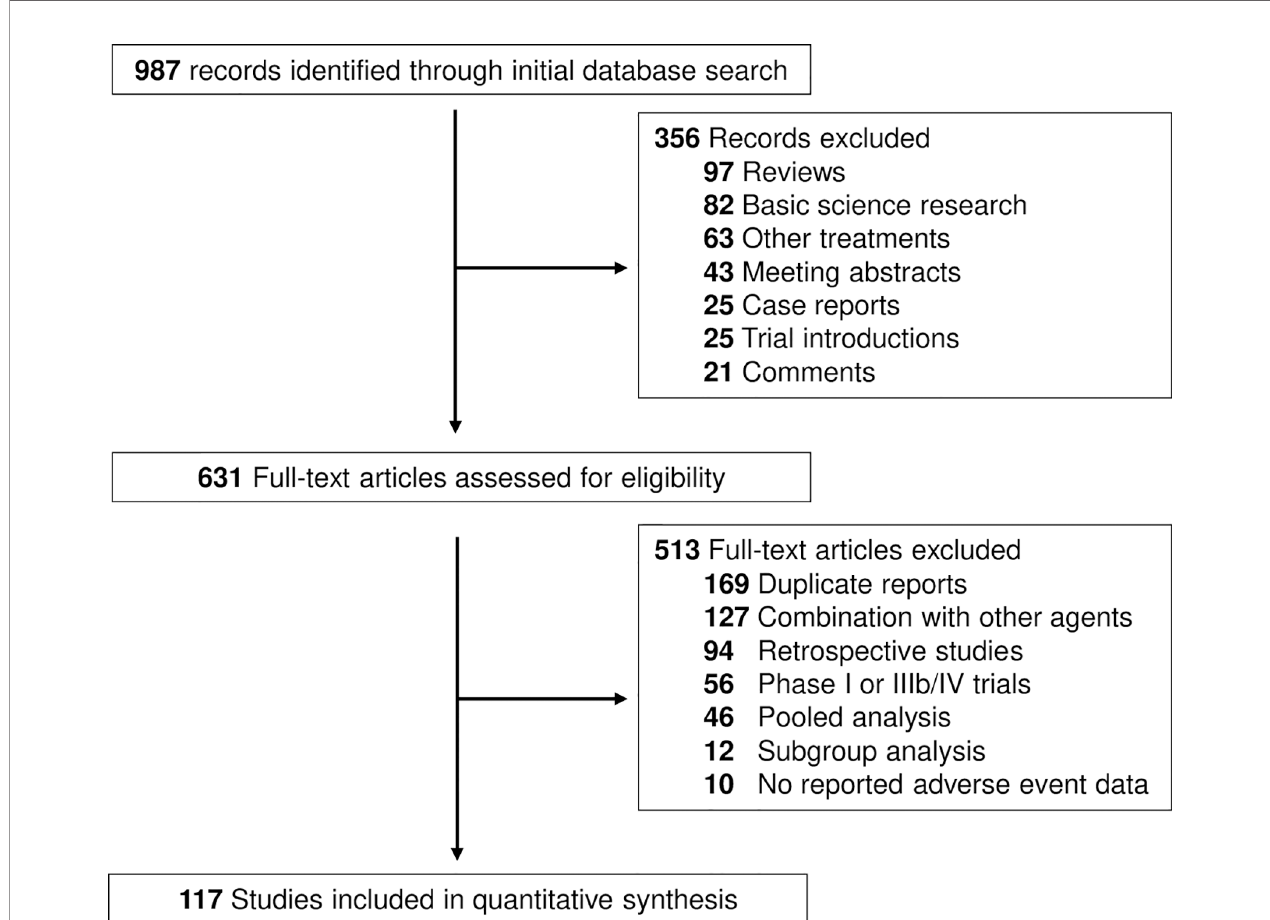
FIGURE 1 | Flow diagram of study